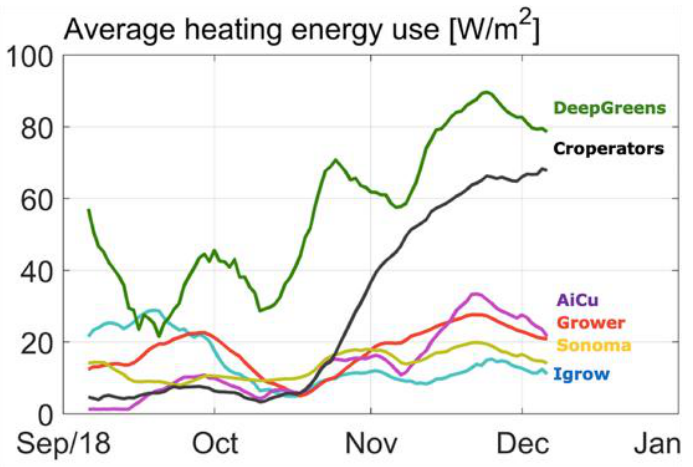
Figure 11. Course of heating energy use in di ff erent compartments during the cucumber